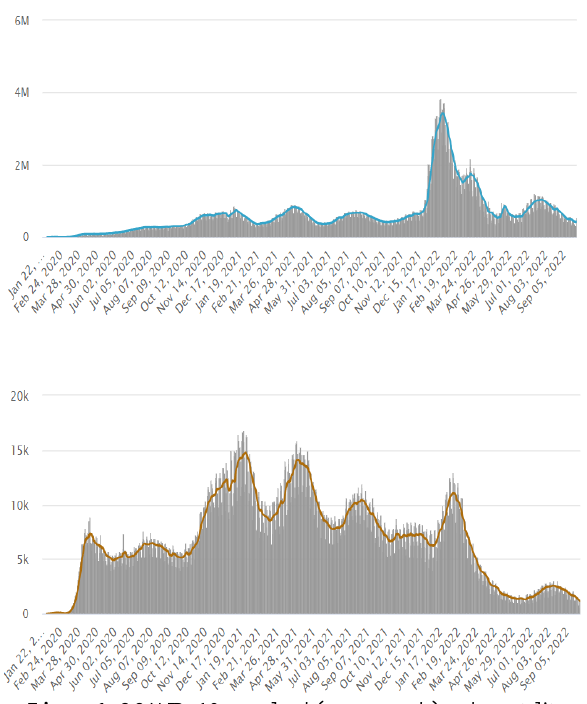
Figure 1 . COVID-19 case load (upper graph) and mortality (lower graph) world-wide as of September 5, 2022. Also, the results of daily new case and death in Iran illustrated in Figure